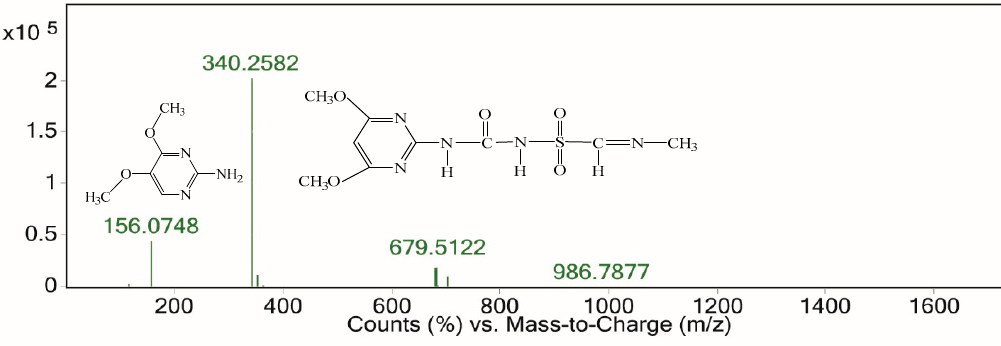
Figure 14. ESI spectrum from 7.192 min to 7.309 min.